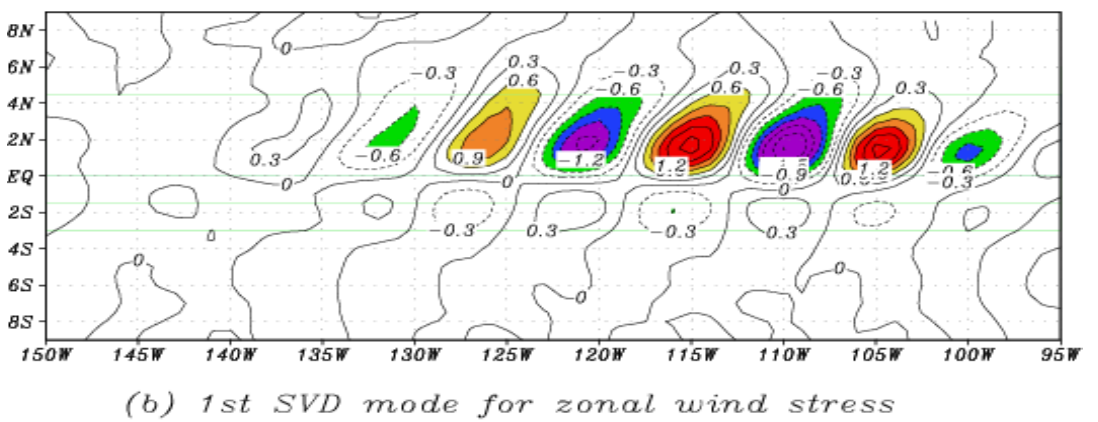
Figure 3. Spatial patterns of the first pair of eigenvectors for ( a ) SST and ( c ) meridional τ components, respectively. The SVD analysis is performed using the TIW TMI SST and QuikSCAT wind satellite data during the periods 2000–2007. The contour interval is 0.3 in (a) and 0.1 in